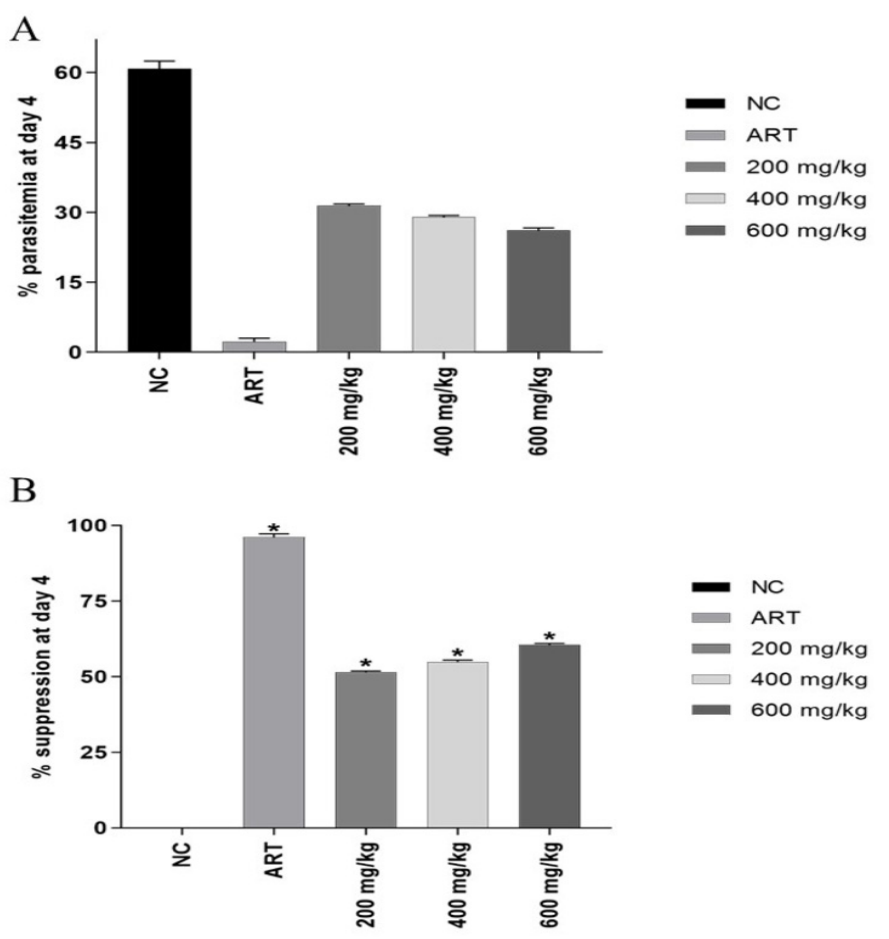
Figure 1. Effect of ethanolic extract of G. malaccensis (200, 400, and 600 mg/kg body weight) on the percent parasitemia ( A ) and percent suppression ( B ) in Plasmodium berghei -infected mice in the 4-day suppressive test compared to the negative control (NC) and positive control (artesunate; ART). Data are expressed as mean ± SEM (n = 5 per group), * Compared to negative control, p < 0.05.